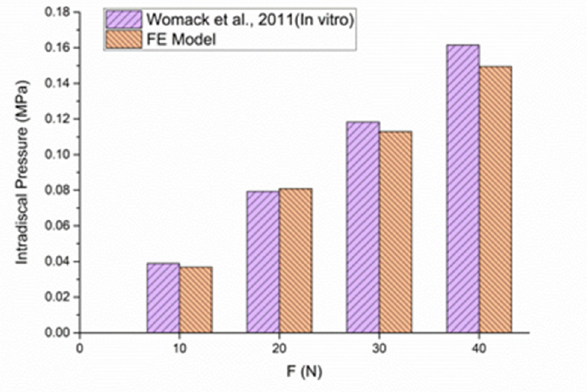
Figure 6. Intervertebral disc stress on segments C4-C5 under axial compression (data from [39]).